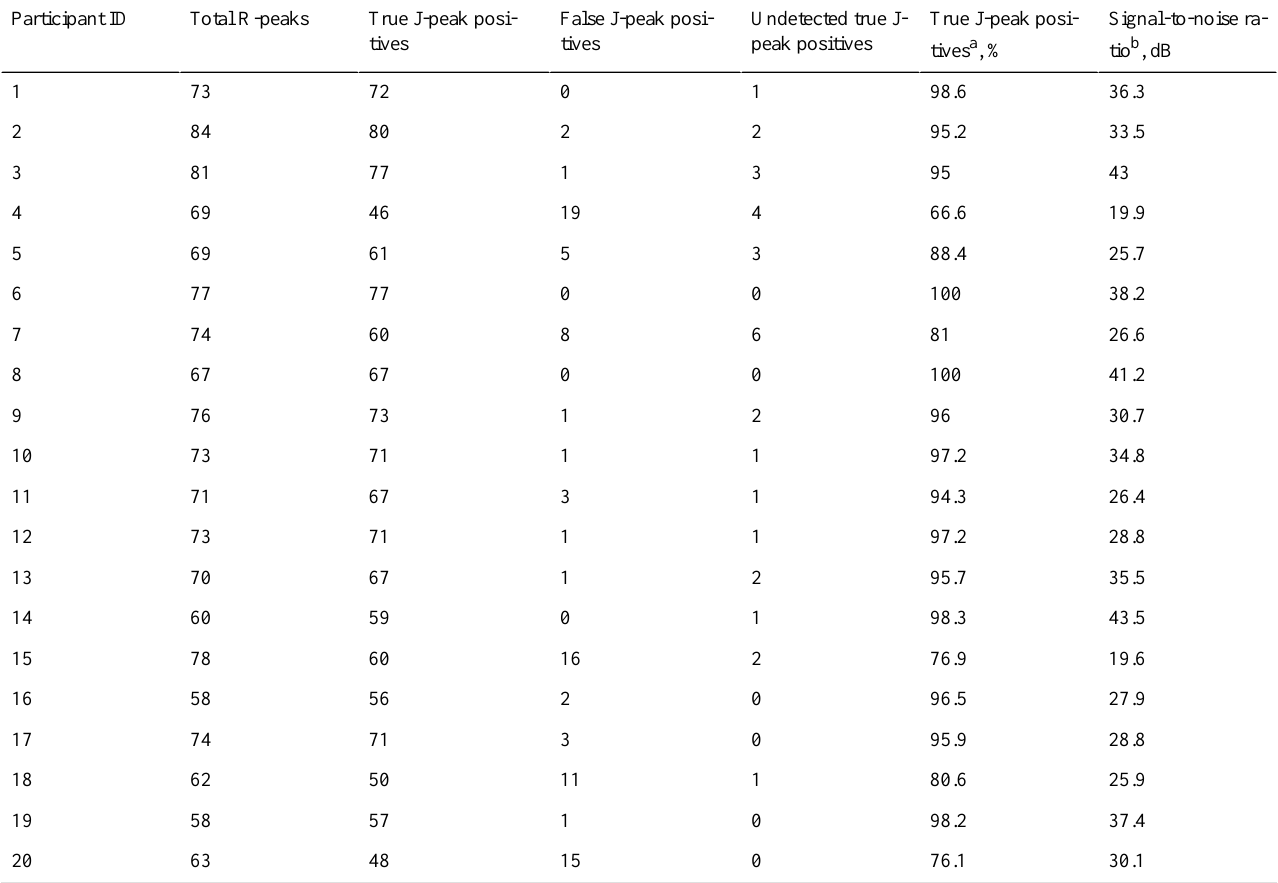
Table 3. Performance analysis of the continuous wavelet transform–based J-peak detection